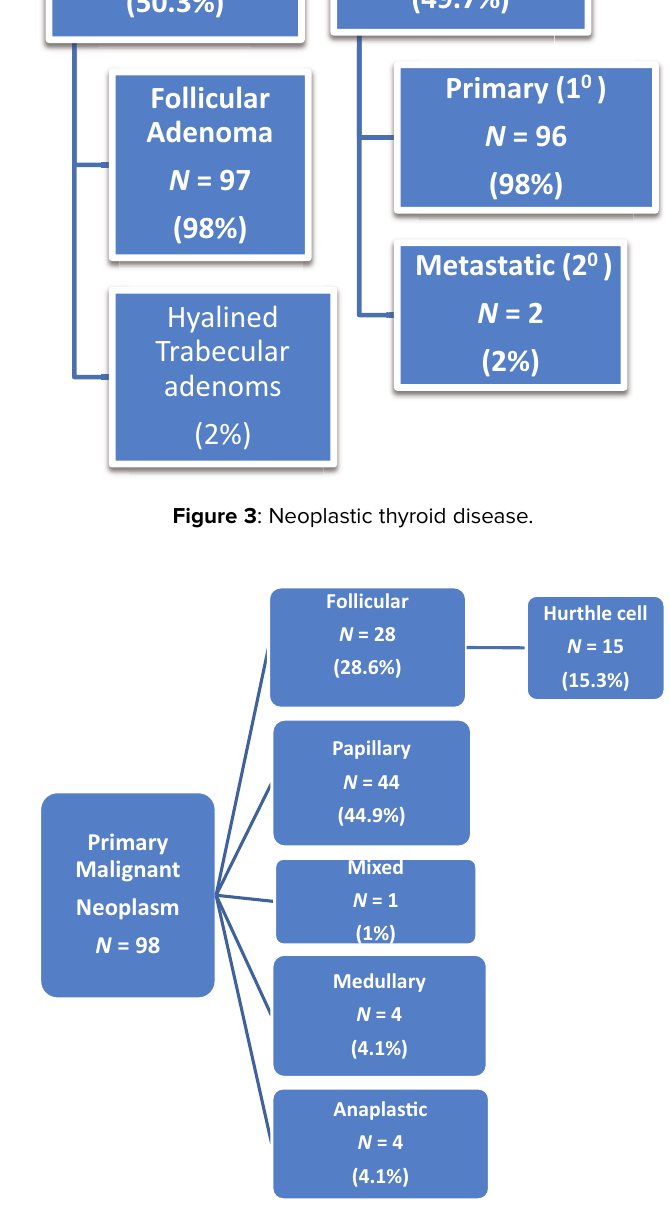
malignant) accounted for nearly equal proportions (50.3 percent and 49.7 percent, respectively) Thyroid neoplasms (benign and